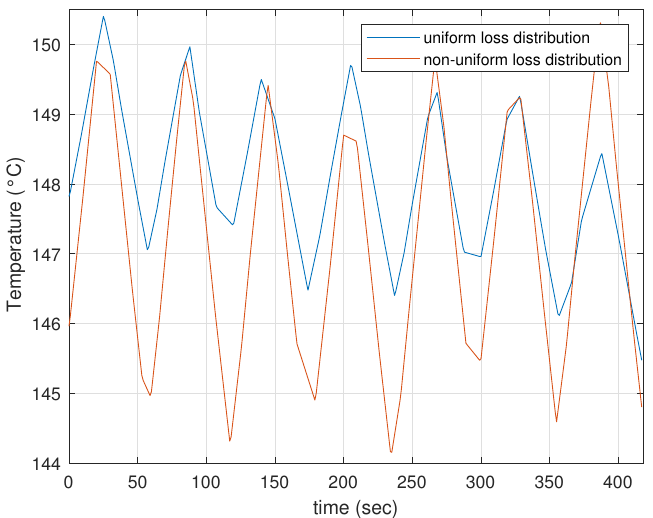
Figure 19. Simulated hotspot temperature variations for a load cycle with a duty cycle of 50% for a case with uniform losses (e.g., when the motor is rotating when producing torque) and for a case with non-uniform losses (e.g., when the motor is at standstill when producing